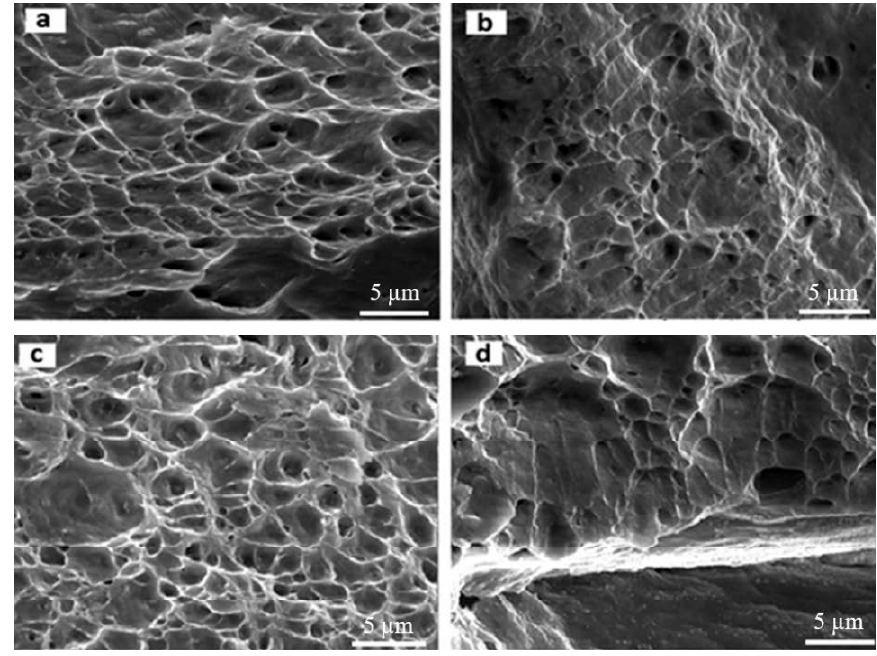
Fig. 11. The SEM images (5000x) of the fracture surfaces of the composites reinforced with micro- (a, b) and nanoparticles (c, d) fabricated by (a, c) first and (b, d) seven cycles of the ARB process.